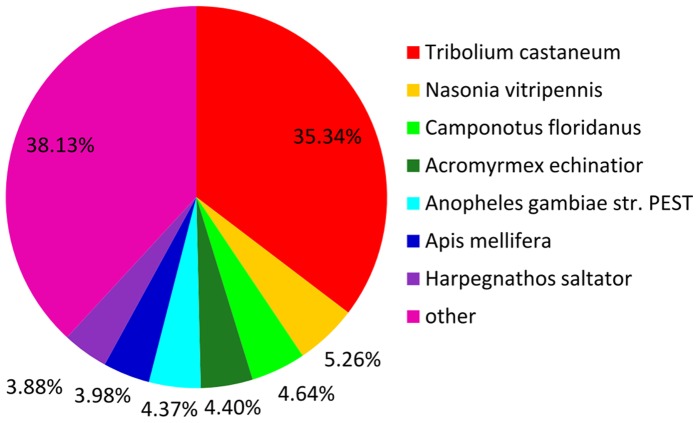
Species distribution of the BLASTX results.Unigenes were searched against the NR protein database using BLASTX with a cutoff e-value <10−5 and the proportions of each species (represented by different colors) graphed. Species with proportions of more than 1% are shown.